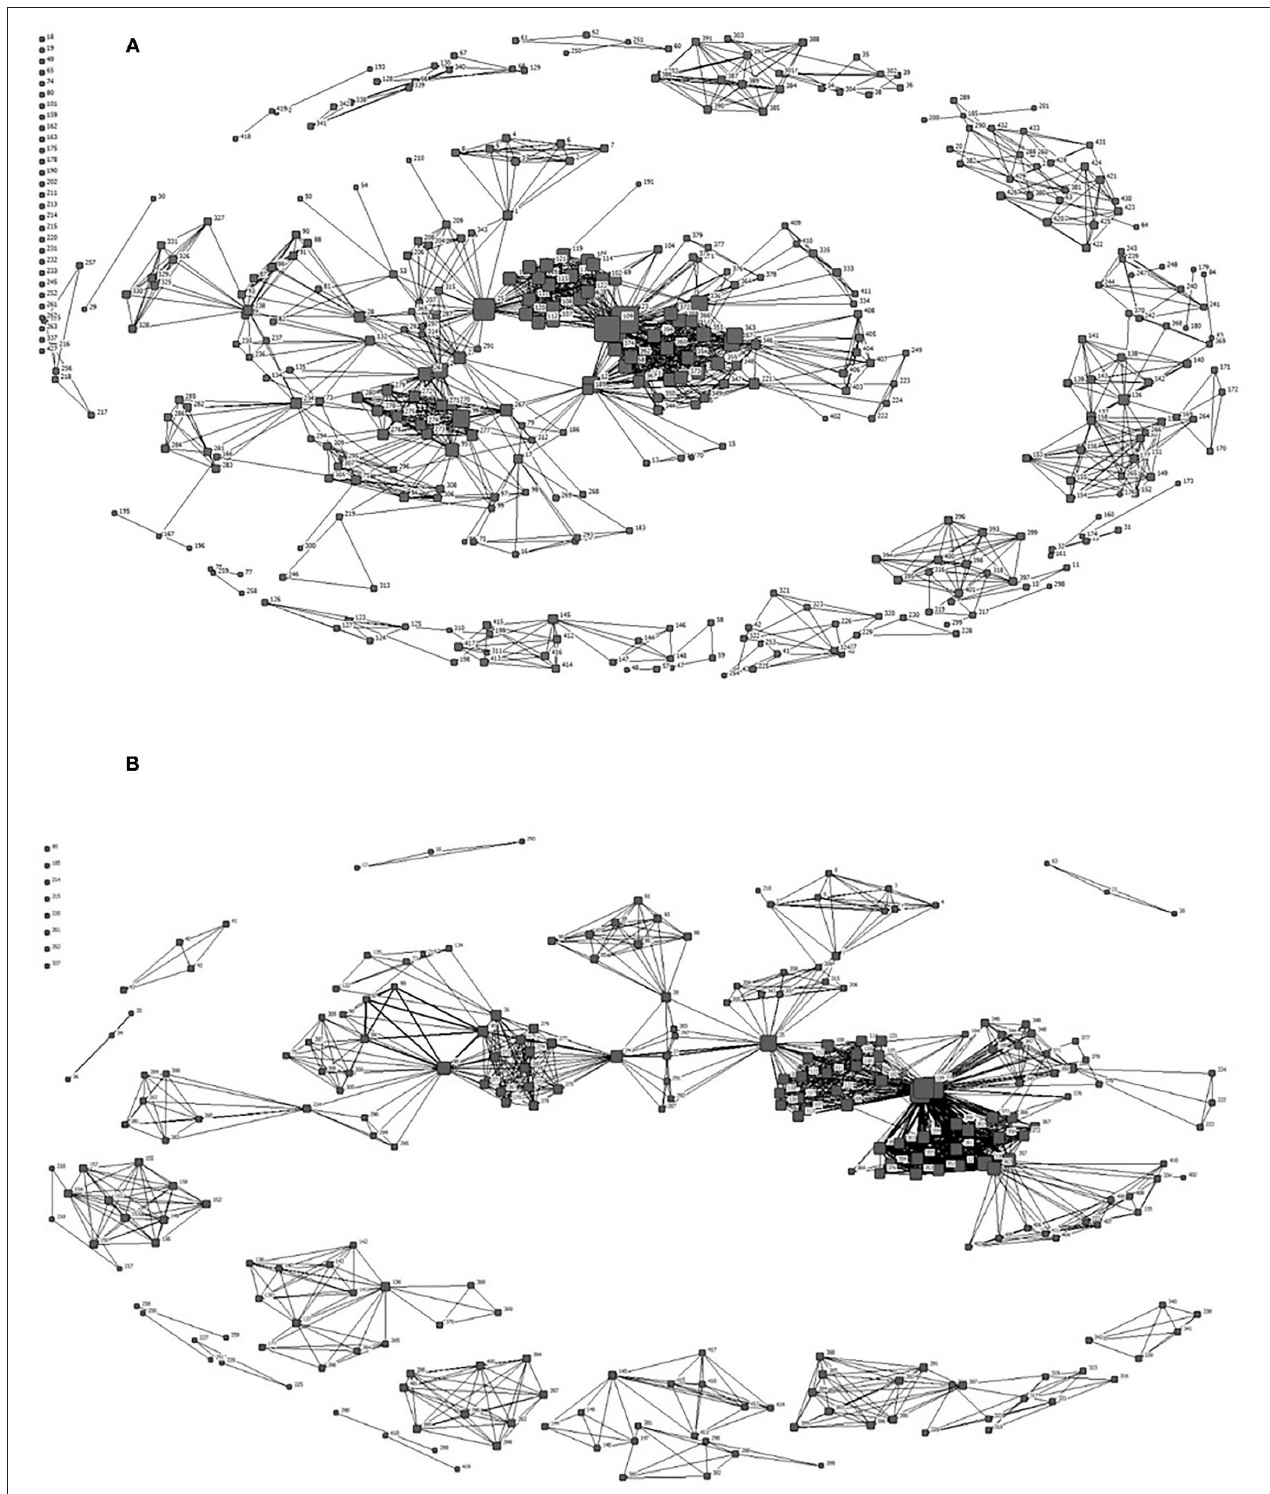
FIGURE 2 | (A) The global co-authorship network of the full network. (B) The co-authorship network of the full network with only the nodes (actors) coauthored more than twice.